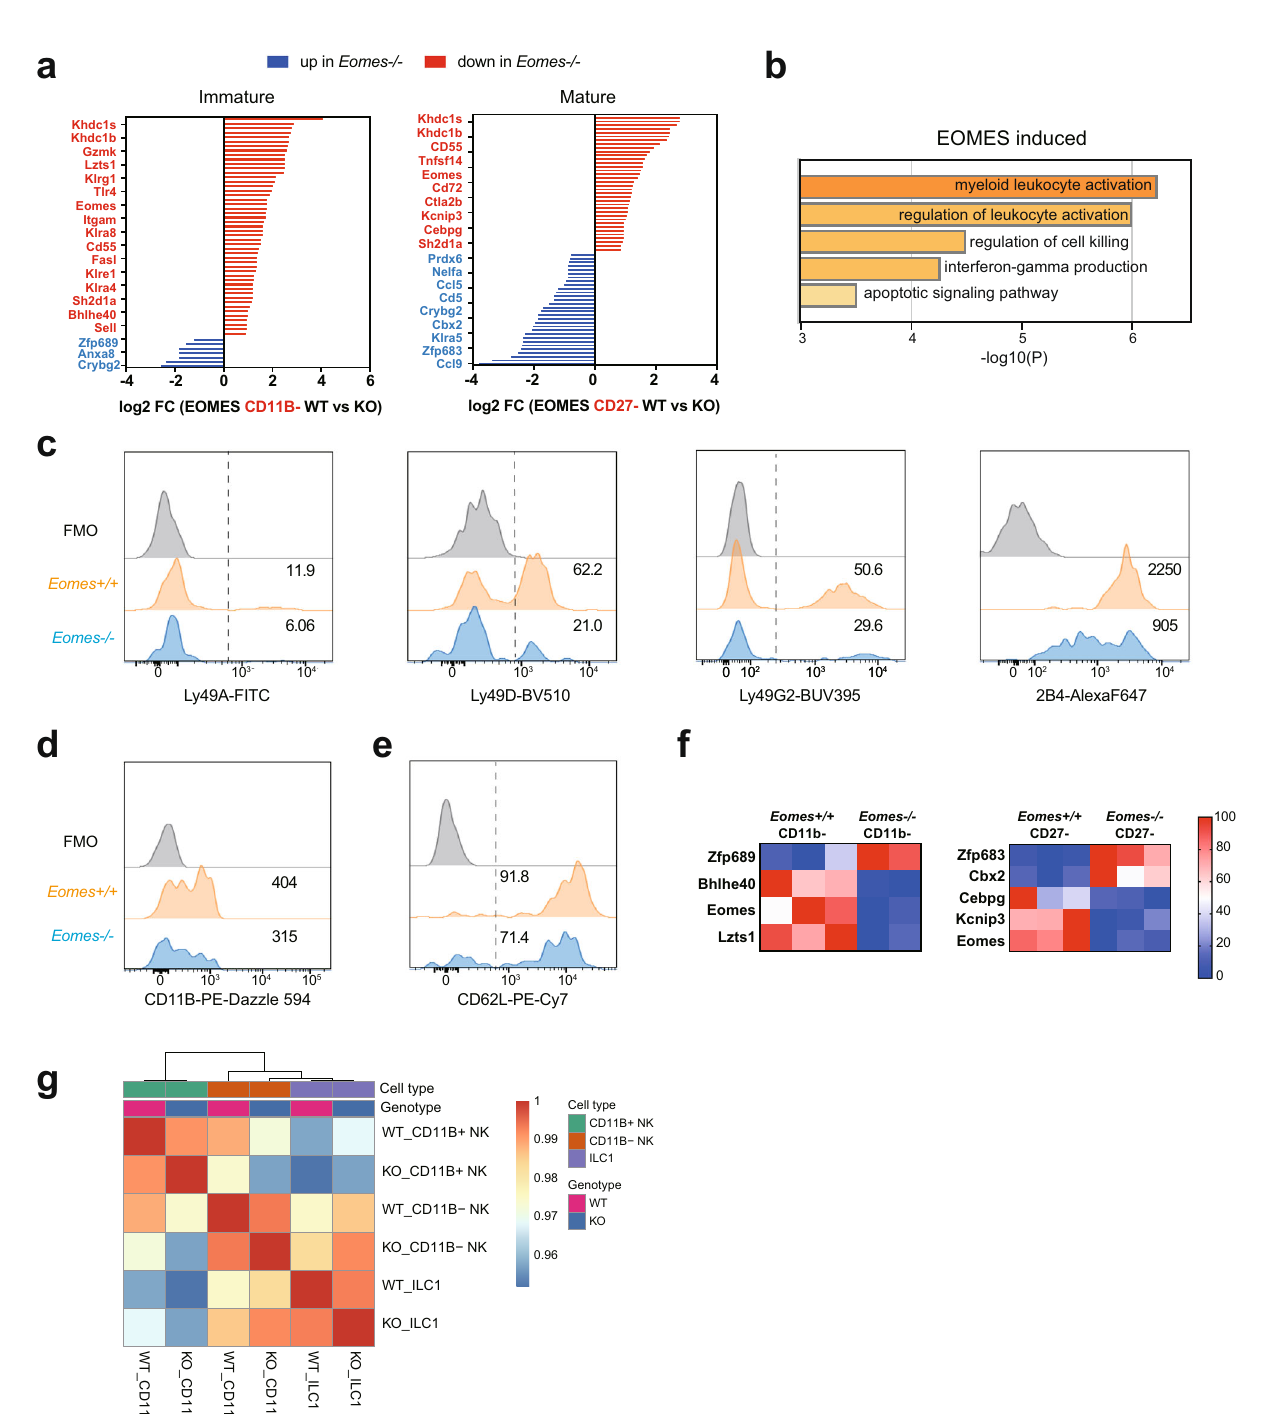
Fig. 6 EOMES-speci fi c role in the induction of hallmark NK cell genes. RNA-seq analysis of sorted Tbx21 − / − , Eomes − / − and appropriate control CD11B- and CD27 − NK cells ( N = 3 per group with three sorts in total). DEGs were selected based on adjusted p < 0.05. a Genes speci fi cally regulated by EOMES in immature or mature NK cells. Bar graph show the log2 transformed fold change between controls and EOMES de fi cient NK cells, as indicated. A few selected gene names are shown. b Functional annotation of the EOMES induced gene set using Metascape. Bar graphs show selected terms among the most signi fi cant ones. c – e Overlayed FACS histograms showing the expression of the indicated surface molecules in EOMES de fi cient vs control immature NK cells, as indicated. Grey histograms show control staining. f Heatmaps showing the log2 transformed fold change in the expression of the indicated TF between control and EOMES de fi cient NK cells. g The indicated subsets were subjected to scRNA-seq analysis as detailed in the methods. The heatmap shows the correlation between averaged pro fi les per sample, calculated on the top 100 most variable